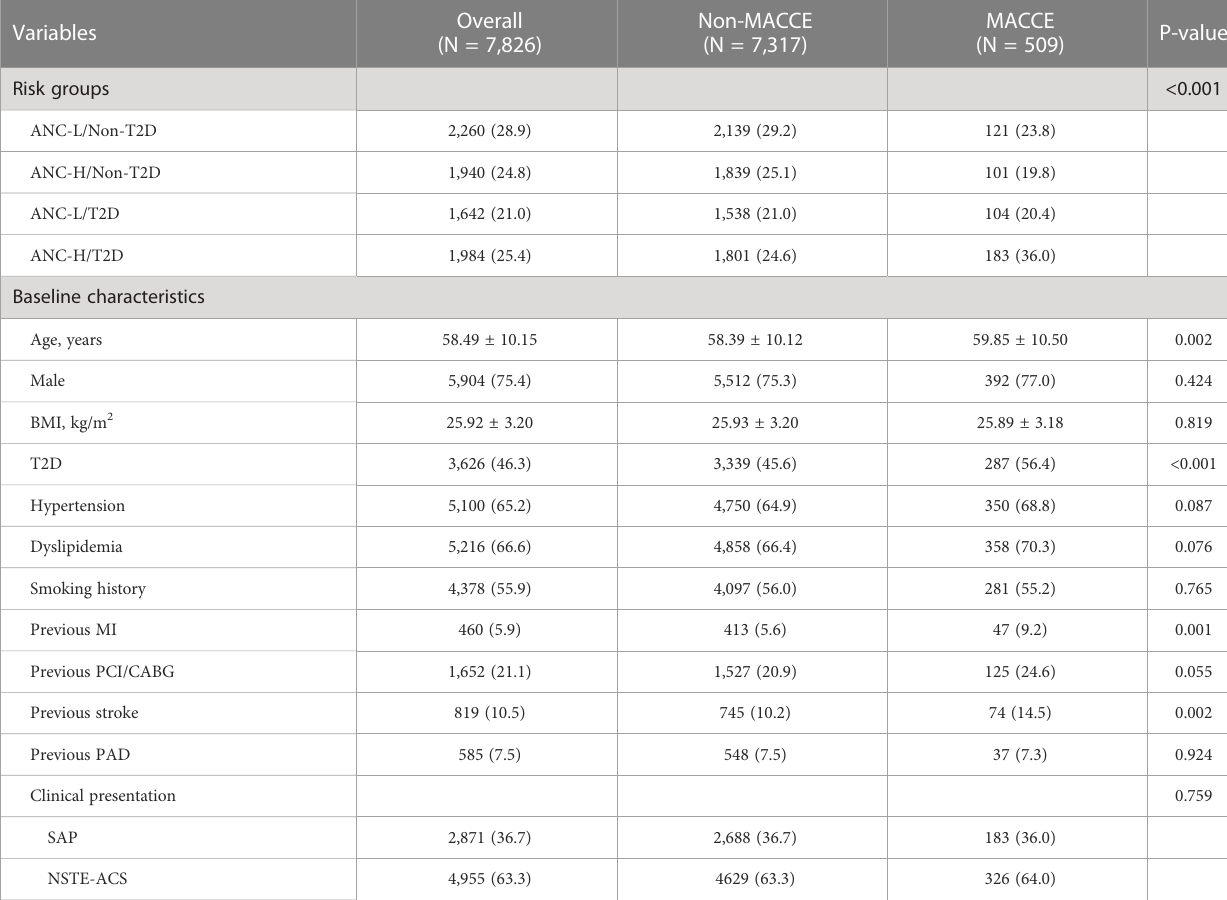
TABLE 1 Baseline characteristics for individuals with or without